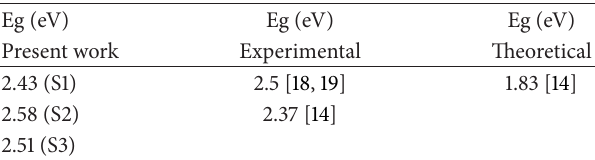
Table 1: Comparison of experimental band gap values of MnWO with literature values.